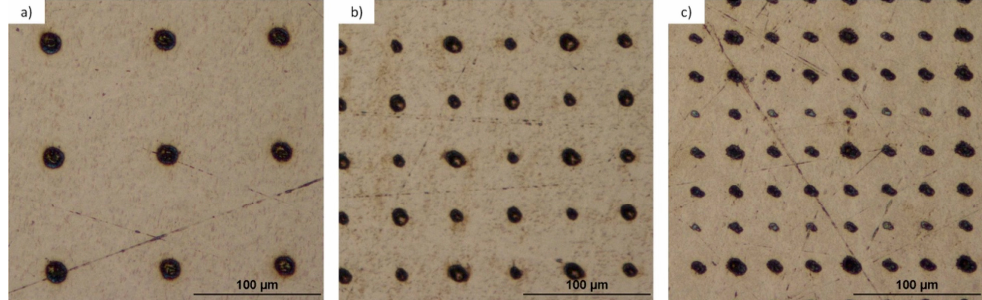
Figure 6. Optical microscope images obtained in reflected mode and bright field of the micropattern over a titanium foil of 0.7 mm thickness obtained after the ablation using the foci of the microlenses when the surface is placed at the ( a ) first Talbot distance; ( b ) 3/2 Talbot distance; and ( c ) 5/3 Talbot